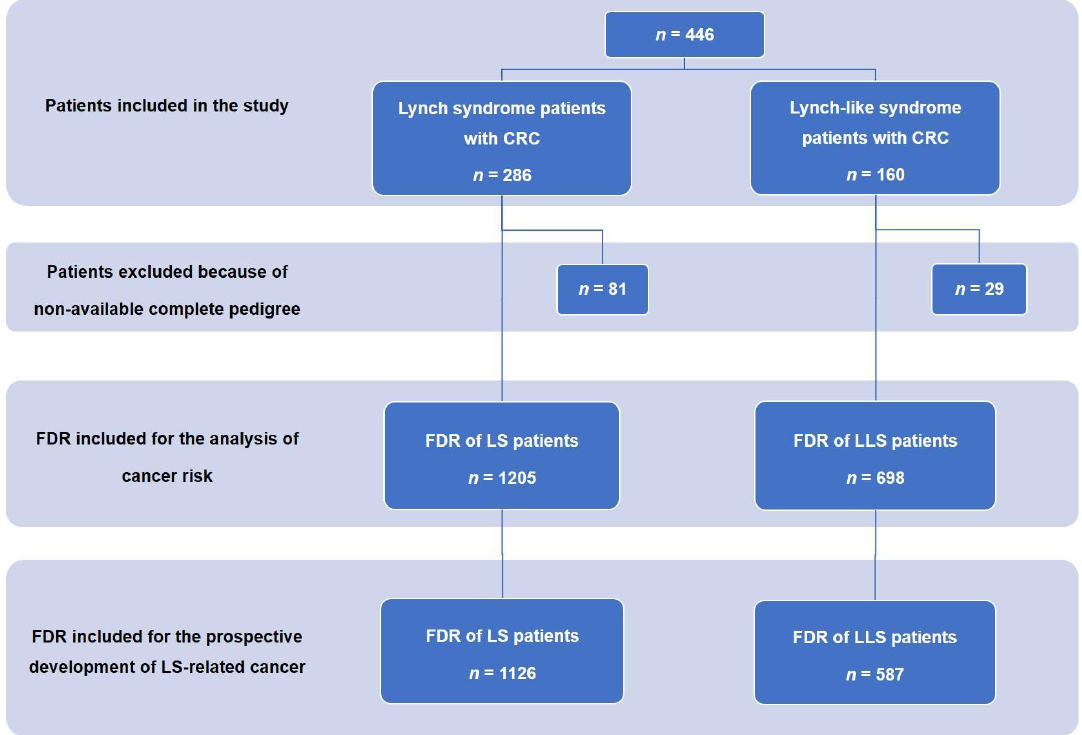
Figure 1. Flow diagram of patients and FDR included. FDR, first-degree relatives; LS, Lynch syndrome; LLS, Lynch-like syndrome; CRC, colorectal cancer.